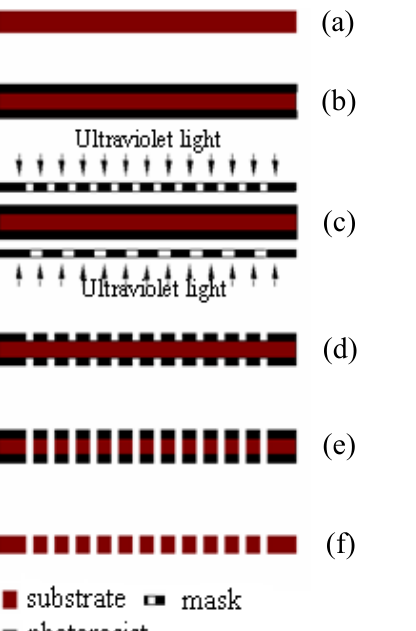
Figure 4. Etching process of the flow field plate. Figure 5. Schematic of the  DMFC test